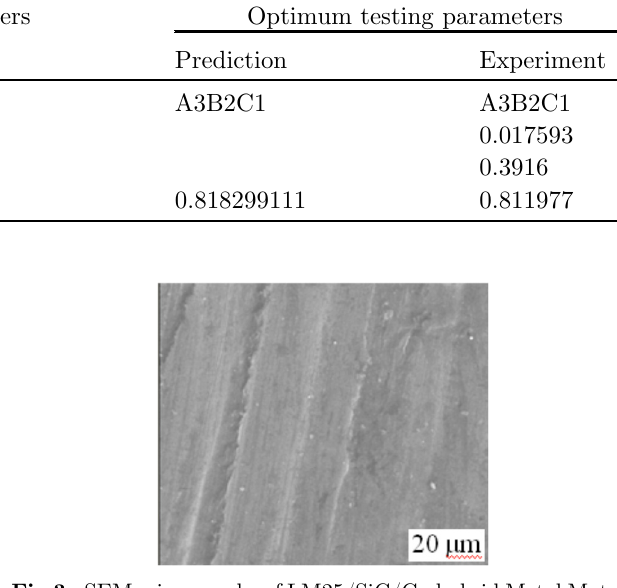
Fig 3. SEM micrographs of LM25/SiC/Cu hybrid Metal Matrix